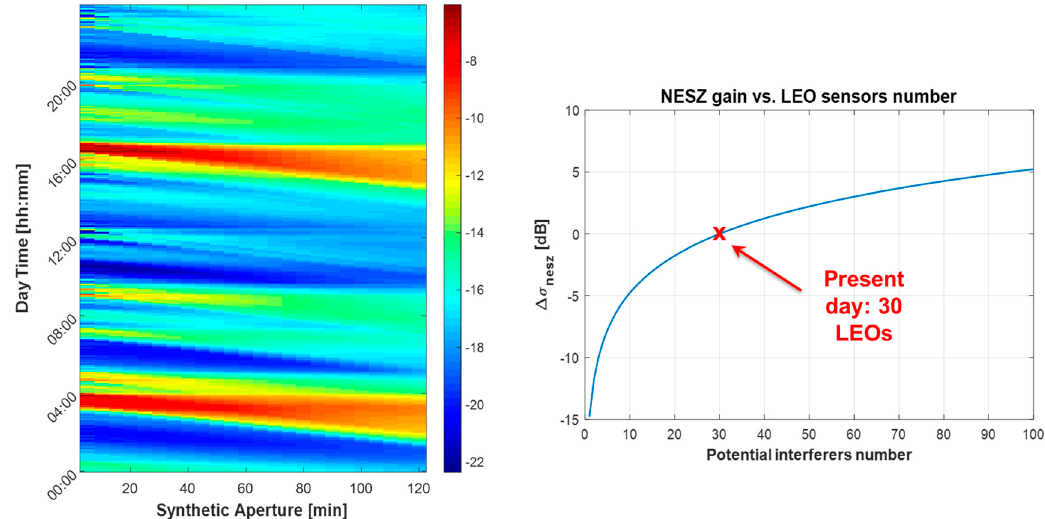
Figure 8. ( Left ) Mean noise equivalent sigma zero (NESZ), computed by assuming as noise the bistatic backscatter from the present scenario of 30 LEO-SARs in Table 1, as a function of the hour of the day and the integration time. ( Right ) variation of the NESZ predicted as function of the number of X-band LEO-SAR.